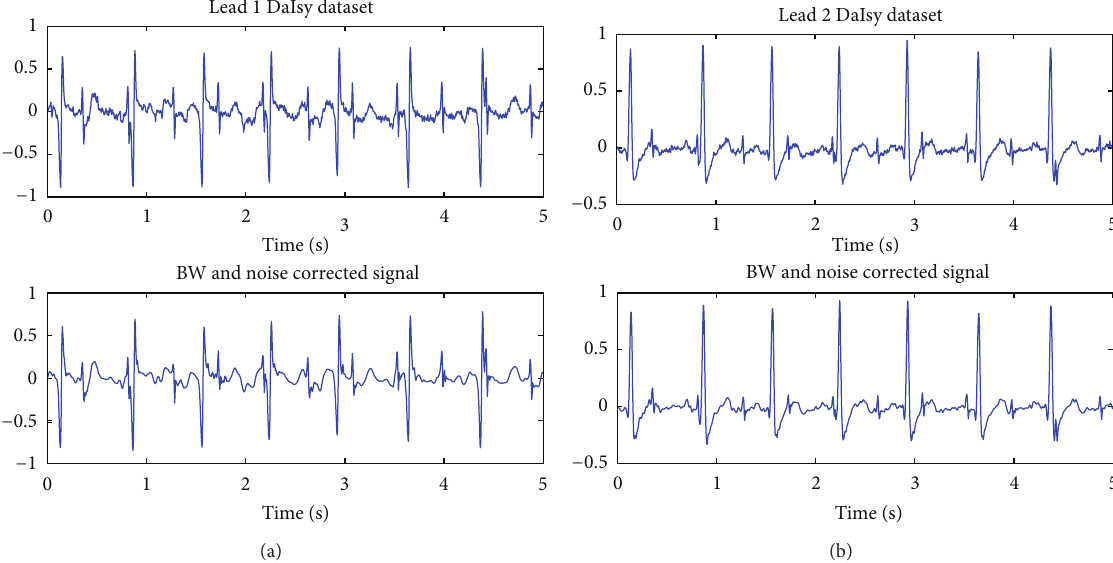
Figure 6: DaIsy database signals: (a) lead 1 and noise and BW corrected signal; (b) lead 2 and noise and BW corrected signals.